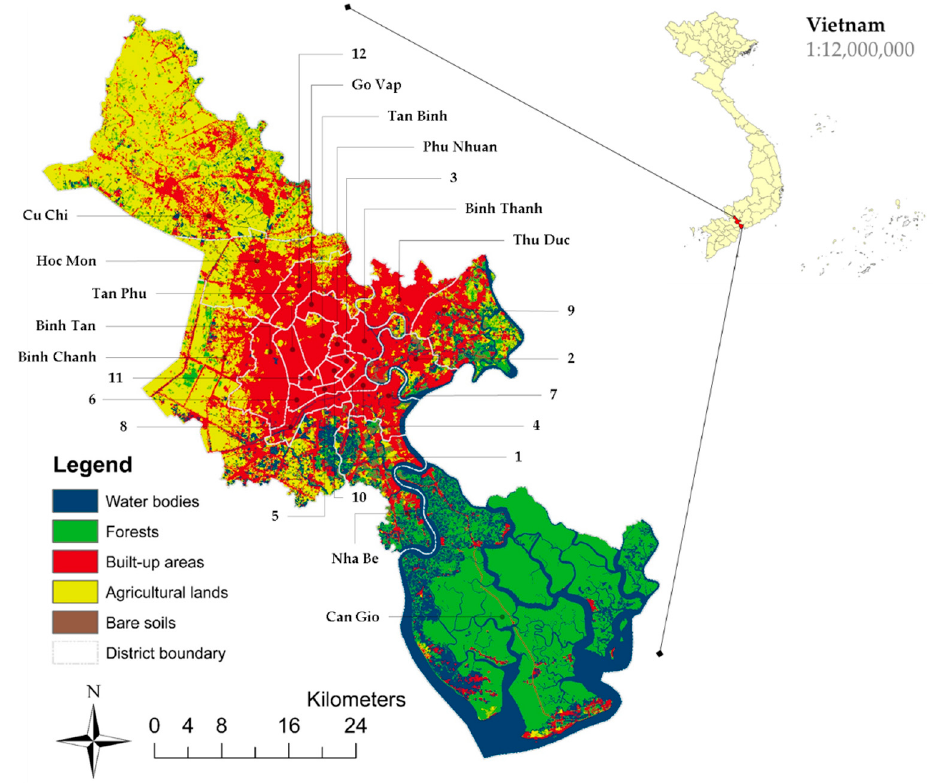
Figure 1. The land use map of Ho Chi Minh City, Vietnam, in 2018.